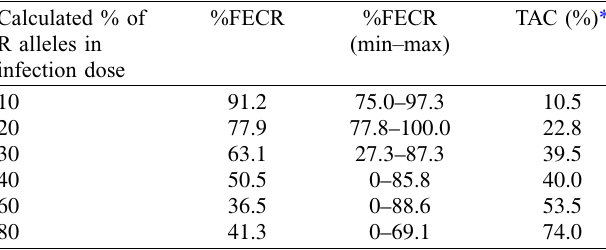
Table 1. Percent faecal egg count reduction (%FECR) and percentage of the codon 200 TAC allele of b -tubulin isotype 1 in the groups of goats infected with different proportions of the resistant and susceptible isolates of Haemonchus contortus